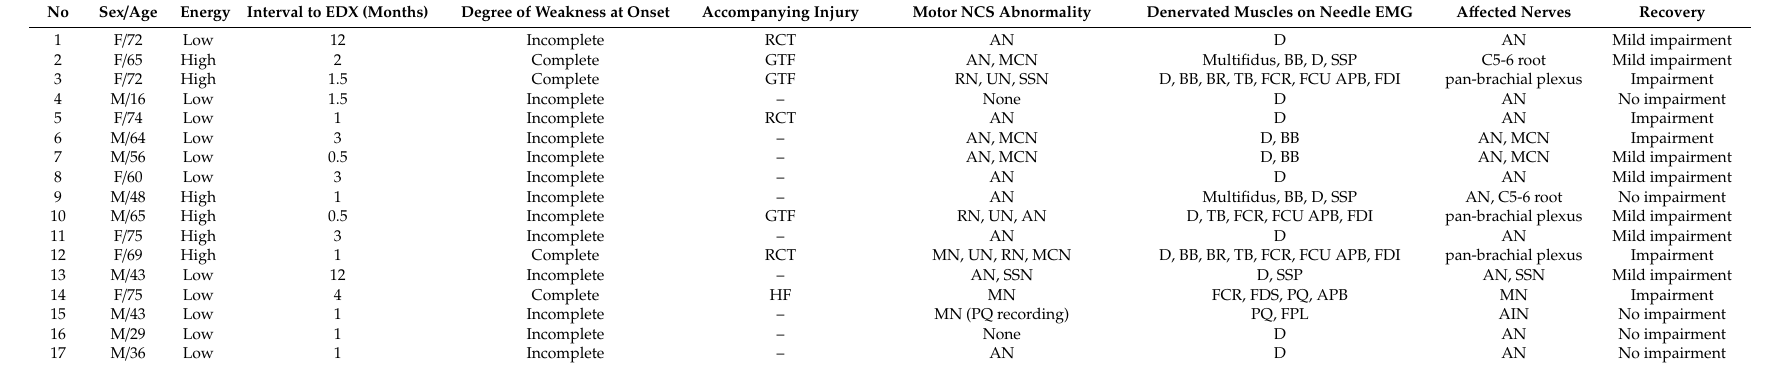
Table 1. Detailed Description of the Peripheral Nerve Injuries in 17 Patients with Shoulder Dislocation.